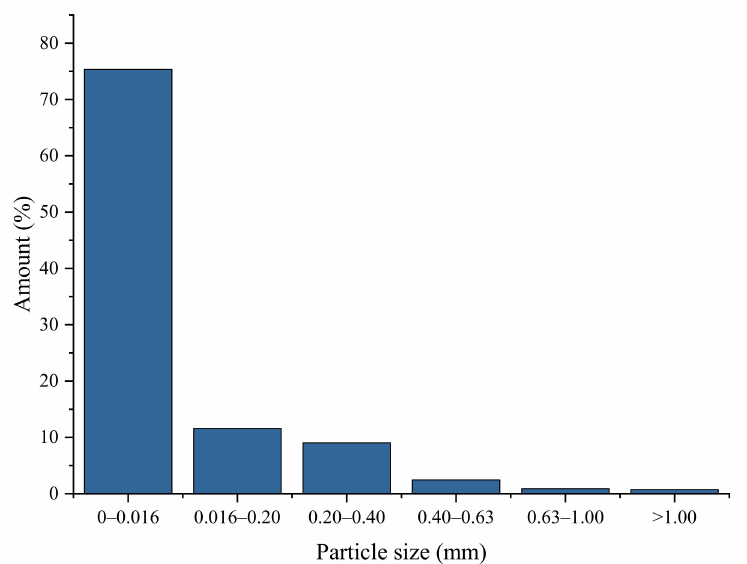
Figure 4. Particle size distribution of sawdust